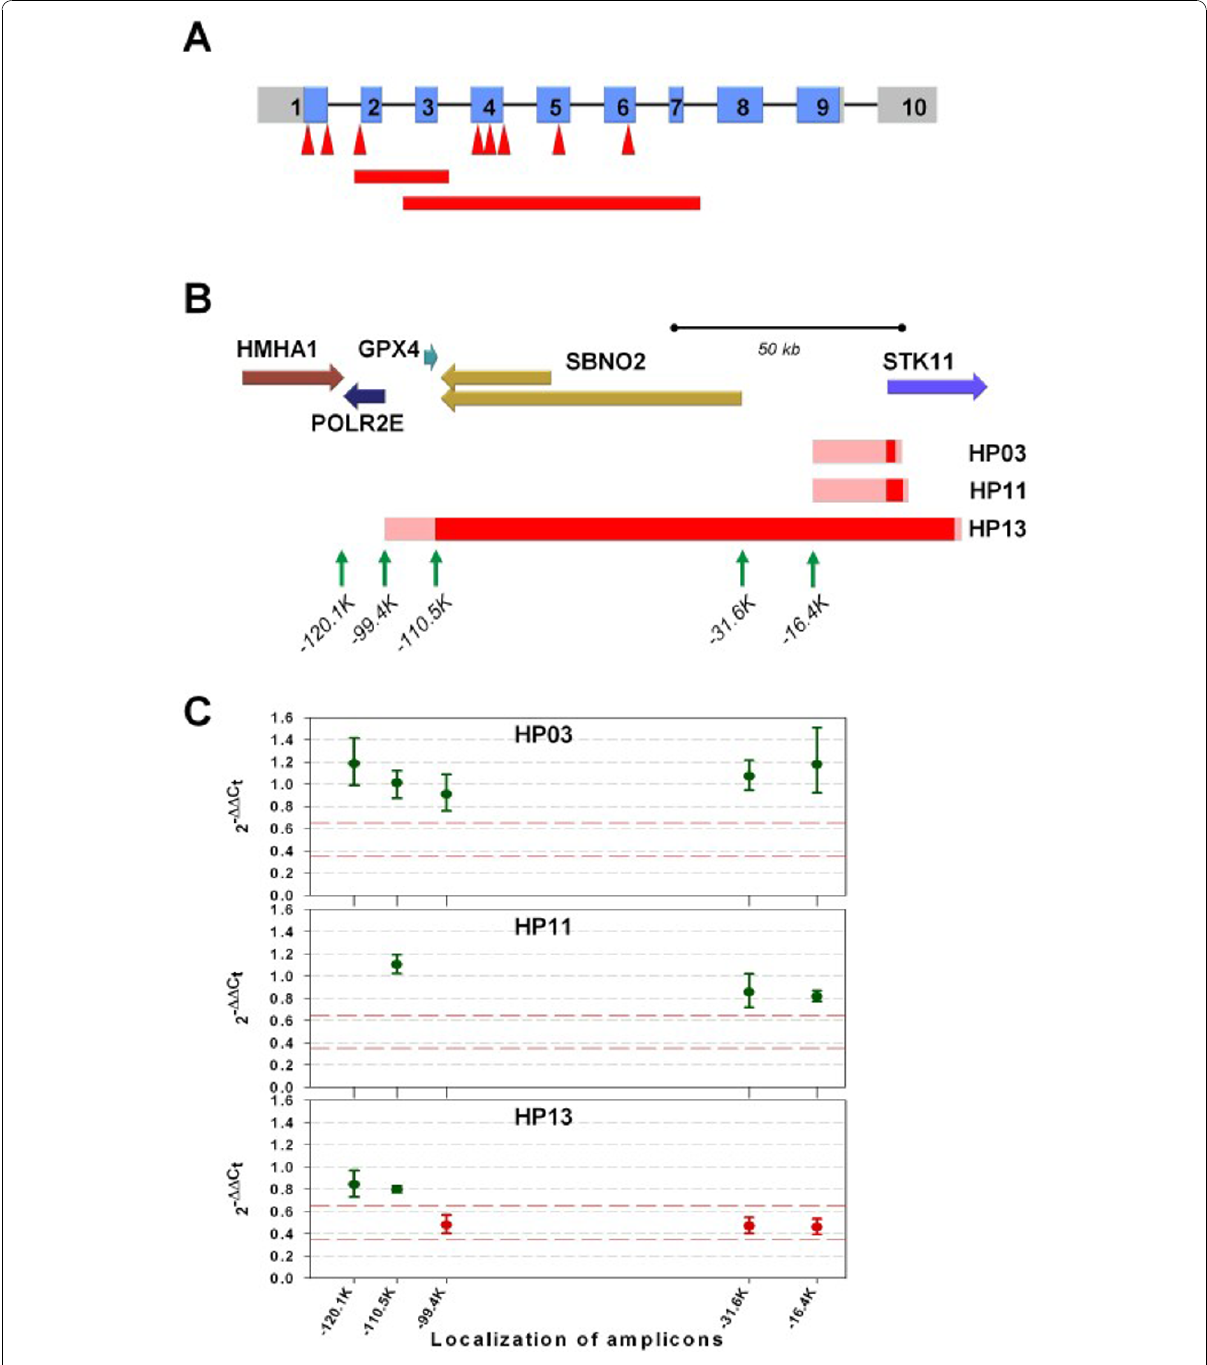
Figure 1 Germline mutations in the STK11 gene . Panel A shows the mutations within the gene: exon structure of the STK11 gene is at the top, the coding region is shown in blue. The introns are not drawn to scale. The locations of point mutations are marked by red arrowheads; the intragenic large deletions are depicted as red rectangles below the gene. The approximate localization of large deletions extending outwards STK11 is portrayed on Panel B. The known RefSeq genes of the region are shown as filled arrows. The minimal and maximal sizes of the large genomic deletions are indicated as red and pink bars, respectively. The loci where copy number analyses were done are marked by vertical green arrows, names reflecting their localization with respect to the STK11 gene. Panel C shows the data of the gene dosage